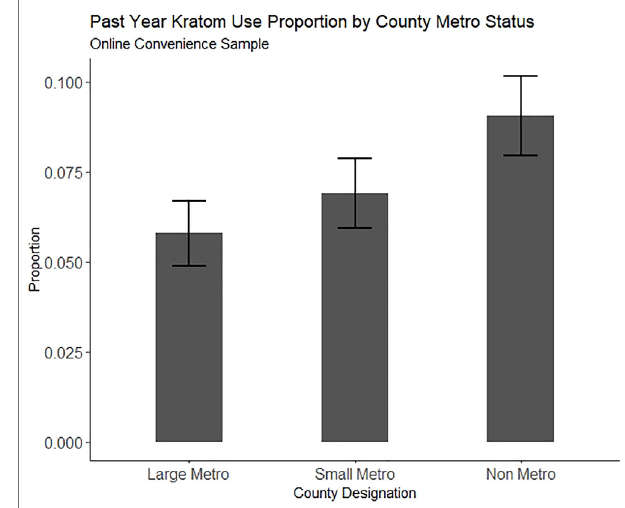
FIGURE 1 | Proportion of people reporting lifetime kratom use in an online convenience sample (N (cid:1) 2,615), split by county metro status. Error bars represent the estimate 95% con fi dence interval.